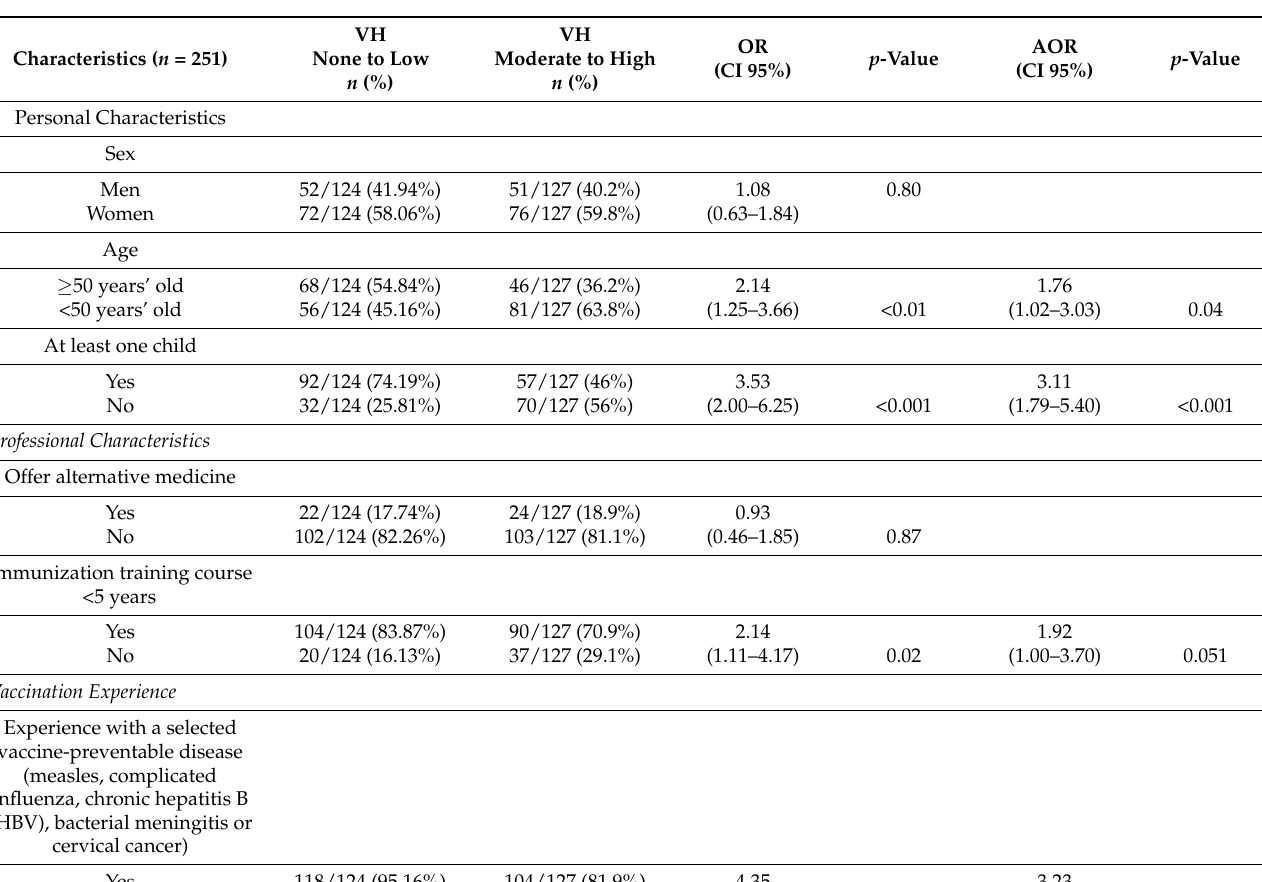
Table 3. Factors associated with moderate to high vaccine hesitancy (VH) in a population of general practitioners ( n = 251). Characteristics ( n =